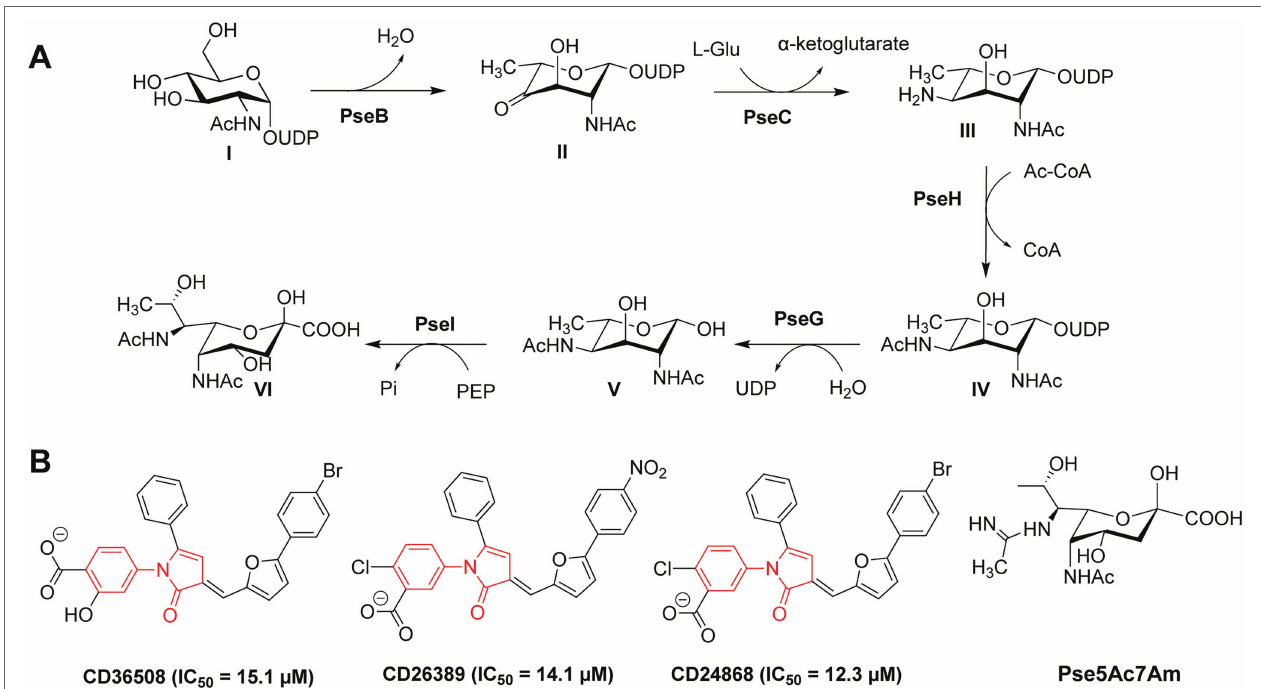
FIGURE 2 | (A) Biosynthetic pathway of Pse in Campylobacter jejuni and Helicobacter pylori ; (B) Structures of the PseB inhibitors CD36508, CD26389, and CD24868 with their respective IC 50 values in μ M (Ménard et al.,